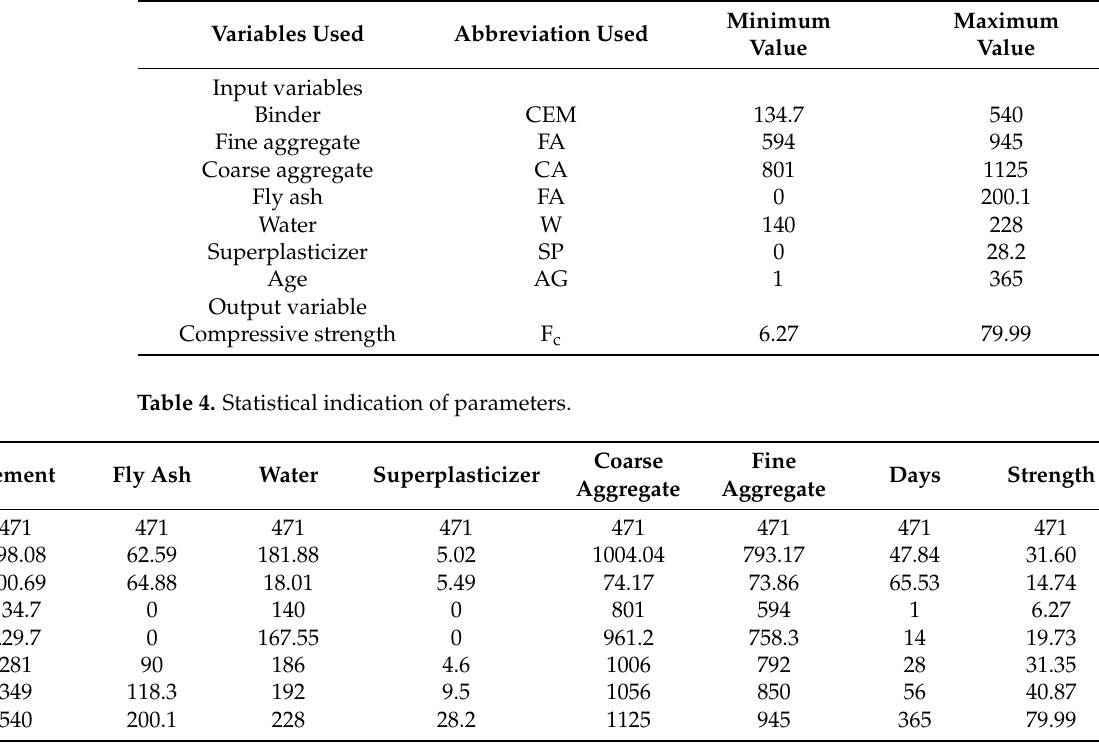
Table 3. Description of input variable ranges.